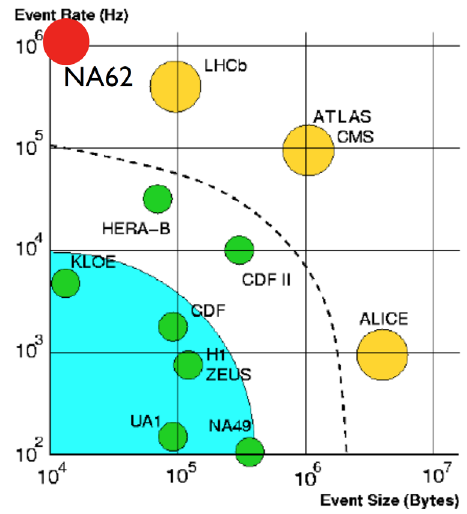
Figure 2. First level trigger event rates and sizes for various experiments, including the NA62 experi- ment which is shown as the red circle. Figure 1. Schematic vertical section through the NA62 experimental setup. The main elements for the detection of the K + decay products are located along a 150 m long region starting 121 m downstream of the kaon production target. Useful K + decays are detected in a 65 m long decay region. Most detectors have an approximately cylindrical shape around the beam axis. An evacuated passage surrounding the beam trajectory allows the intense (750 MHz) flux of un-decayed beam particles to pass through without interacting with detector material before reaching the dump.